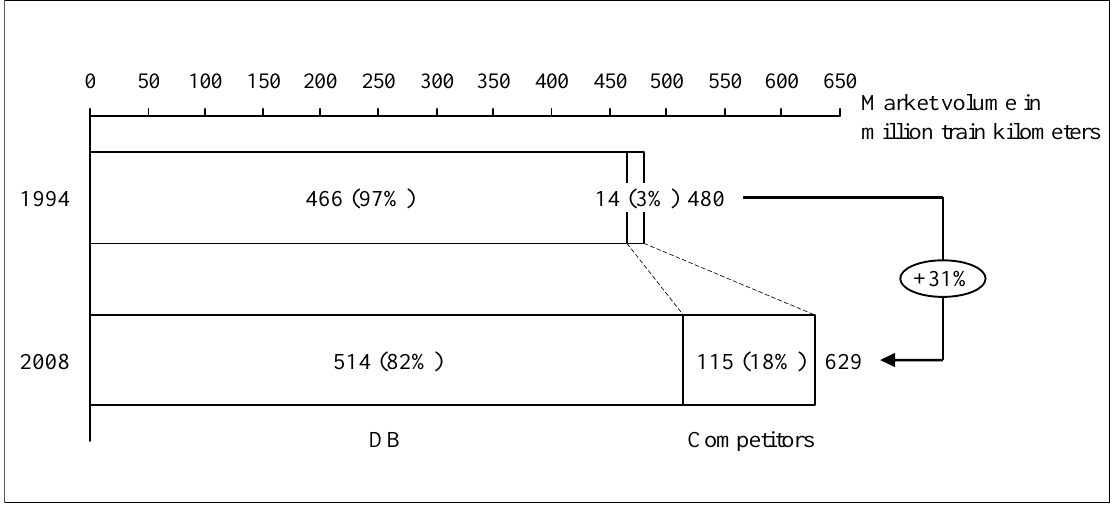
Figure 1. Market development for regional services since market